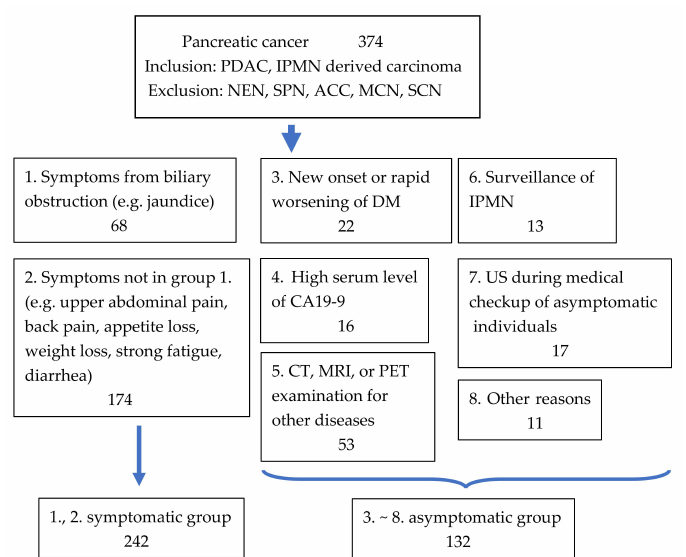
Figure 1. Patient flow diagram. We collected 374 patients with pancreatic cancers (PCs) including those with pancreatic ductal adenocarcinoma (PDAC) and intaraductal papillary neoplasm (IPMN) with high-grade dysplasia, and IPMN associated with invasive carcinoma and excluding those with neuroendocrine neoplasm (NEN), solid pseudo-papillary neoplasm (SPN), acinar cell carcinoma (ACC), mucinous cystic neoplasm (MCN), and serous cystic neoplasm (SCN). We divided patients with PC into 8 groups according to how PC was diagnosed. Patients in group 1 or 2 were defined as the symptomatic group and 3–8 as the asymptomatic group. DM:diabetesmellitus, CA19-9: carbohydrate antigen 19-9, CT: computed tomography, MRI: magnetic resonace imaging, PET: positron emission tomography, IPMN: intraductal papillary mucinous neoplasm, US: abdominal ultrasonography. Diagnostics 2022 , 12 , x FOR PEER REVIEW